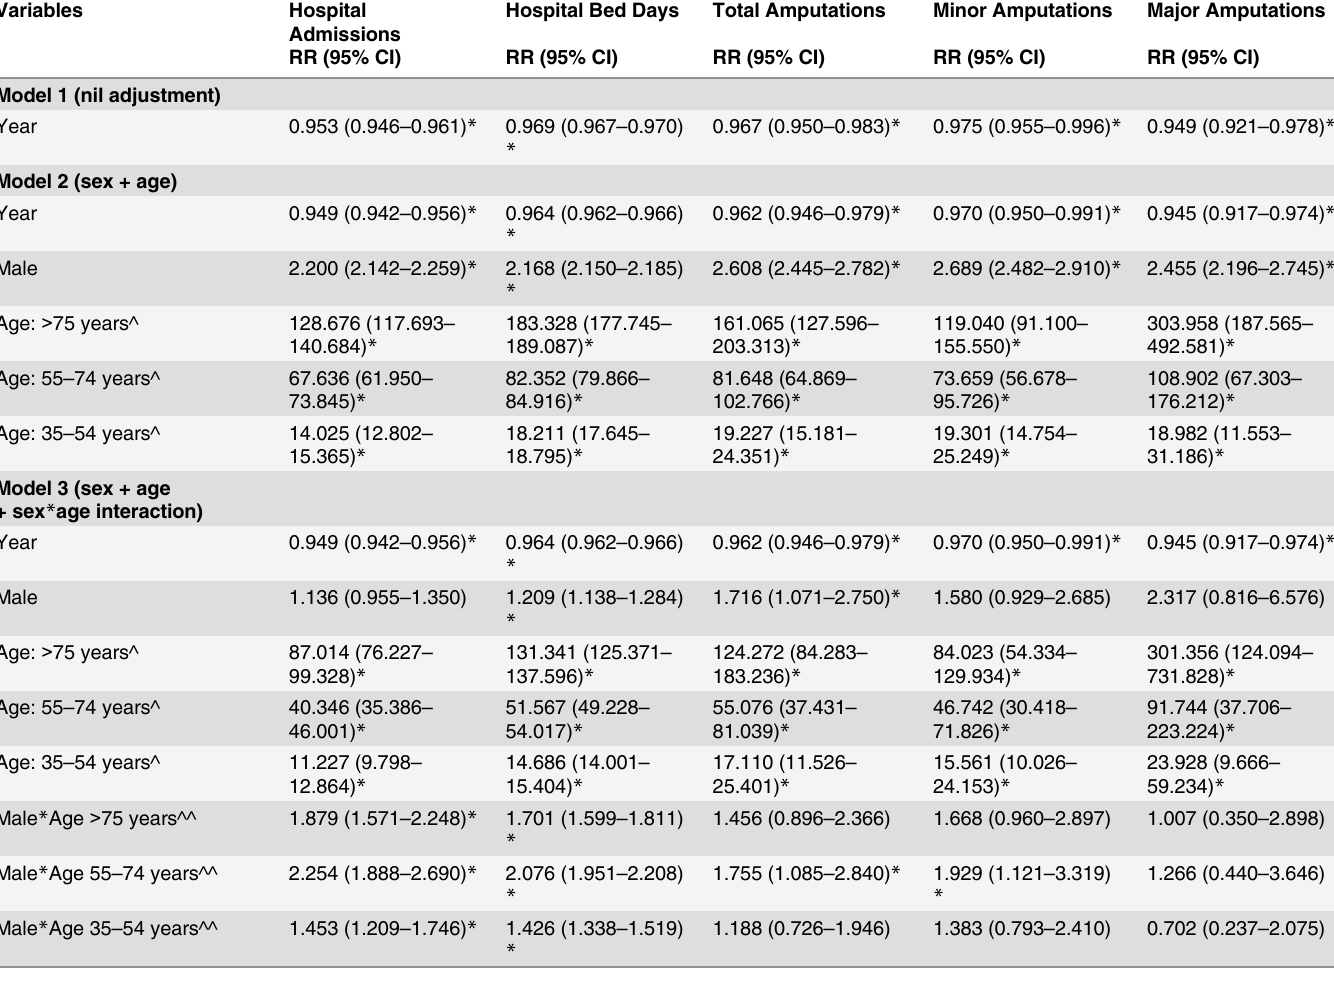
Table 5. Rate ratios of hospitalisation (admissions and bed days) and amputation (total, minor and major) cases in Queensland from 2005 to 2010 with and without adjustment for sex, age and sex * age groups: results from Poisson regression models using calendar year as a continuous